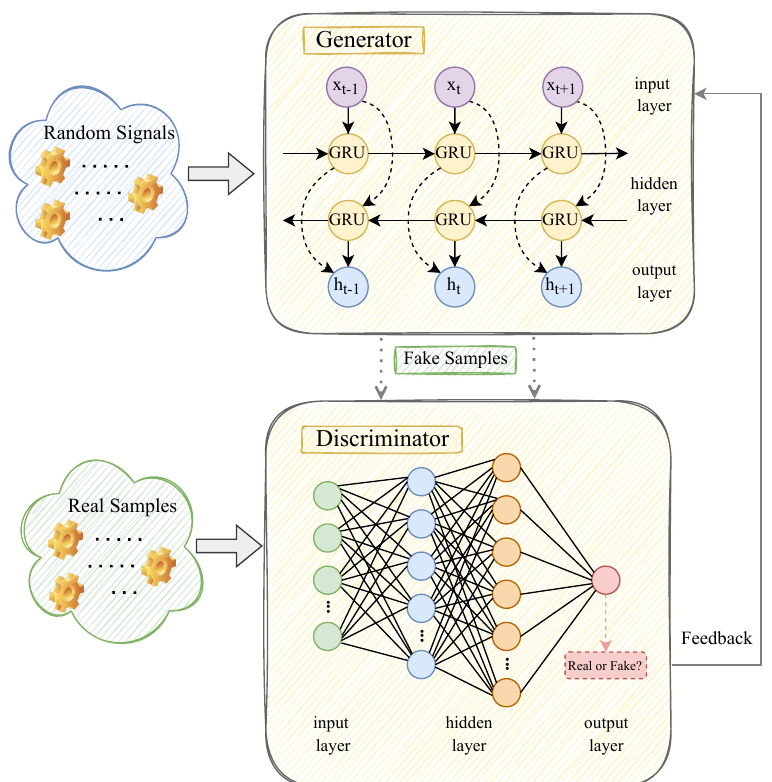
Figure 3. The schematic diagram of the working process of the WGAN neural network.